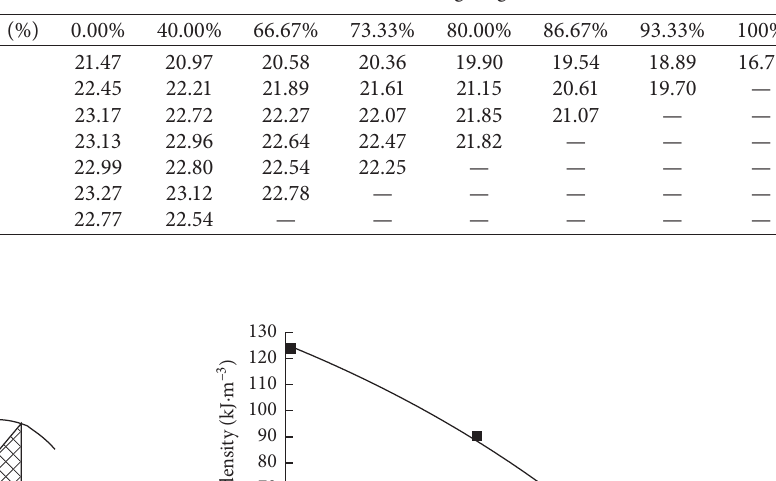
Figure 9: Change curves of the deformation modulus. (a) The curve of deformation modulus and unloading quantity at the unloading stage. (b) The curve between percentage change of deformation modulus and unloading quantity. Table 2: Statistical table of the deformation modulus at the unloading stage.